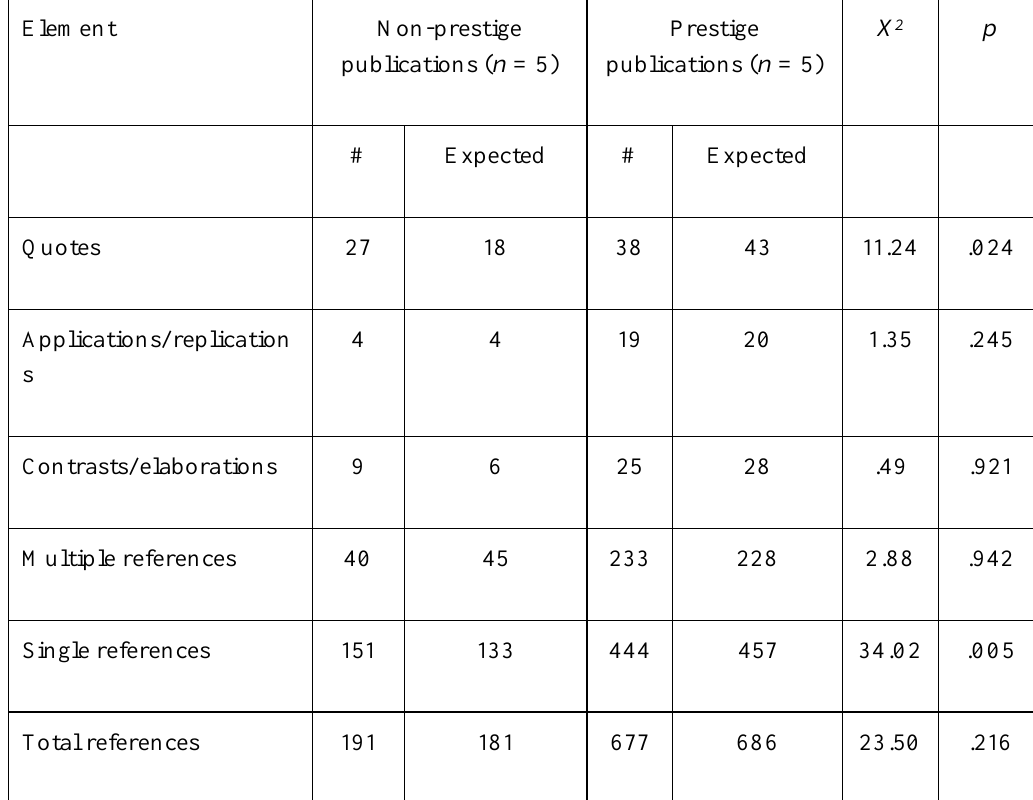
Usage by Others based on the Prestige or Non-Prestige Status of the Publication in which the Target Paper